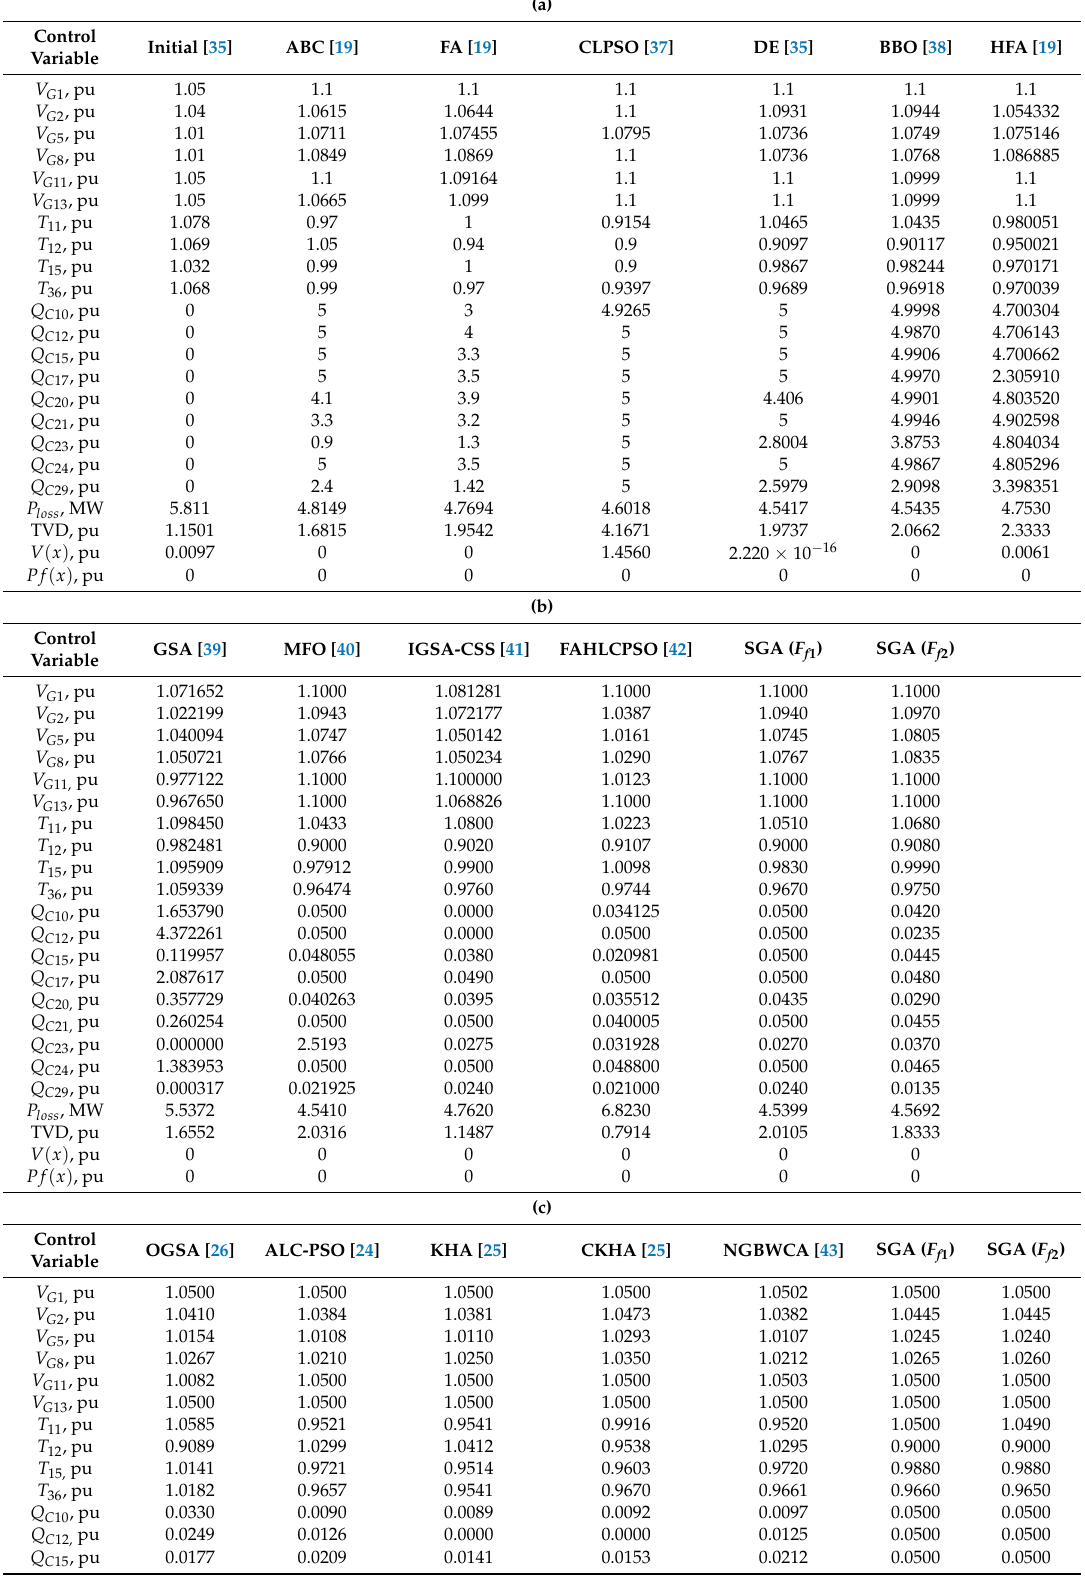
Table 5. Best control variable settings reported for power loss minimization of the IEEE 30 bus test system with different algorithms considering 1.1 pu as the maximum setpoints of